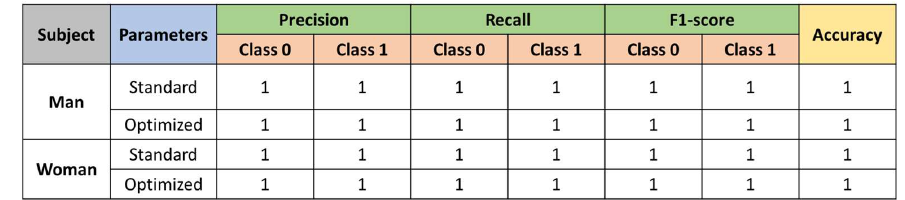
Figure 13. Results of the XGBoost classifier.